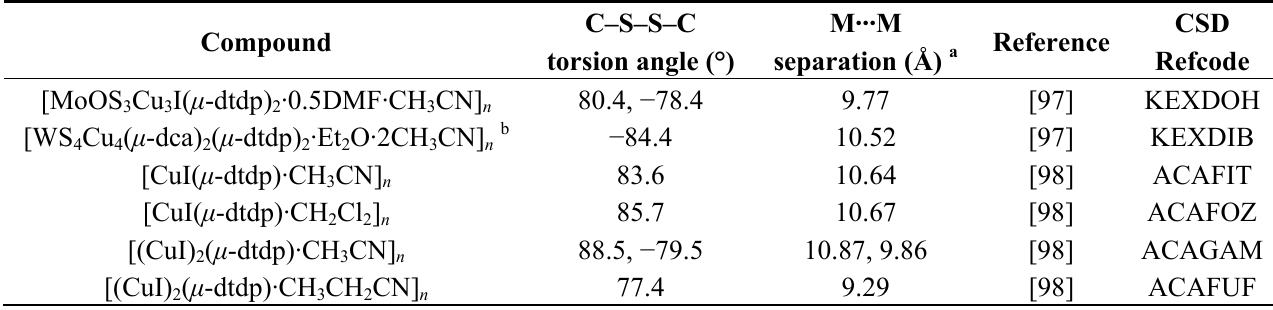
Table 6. Selected structural parameters for coordination polymers based on metal sulfide or metal iodide clusters.